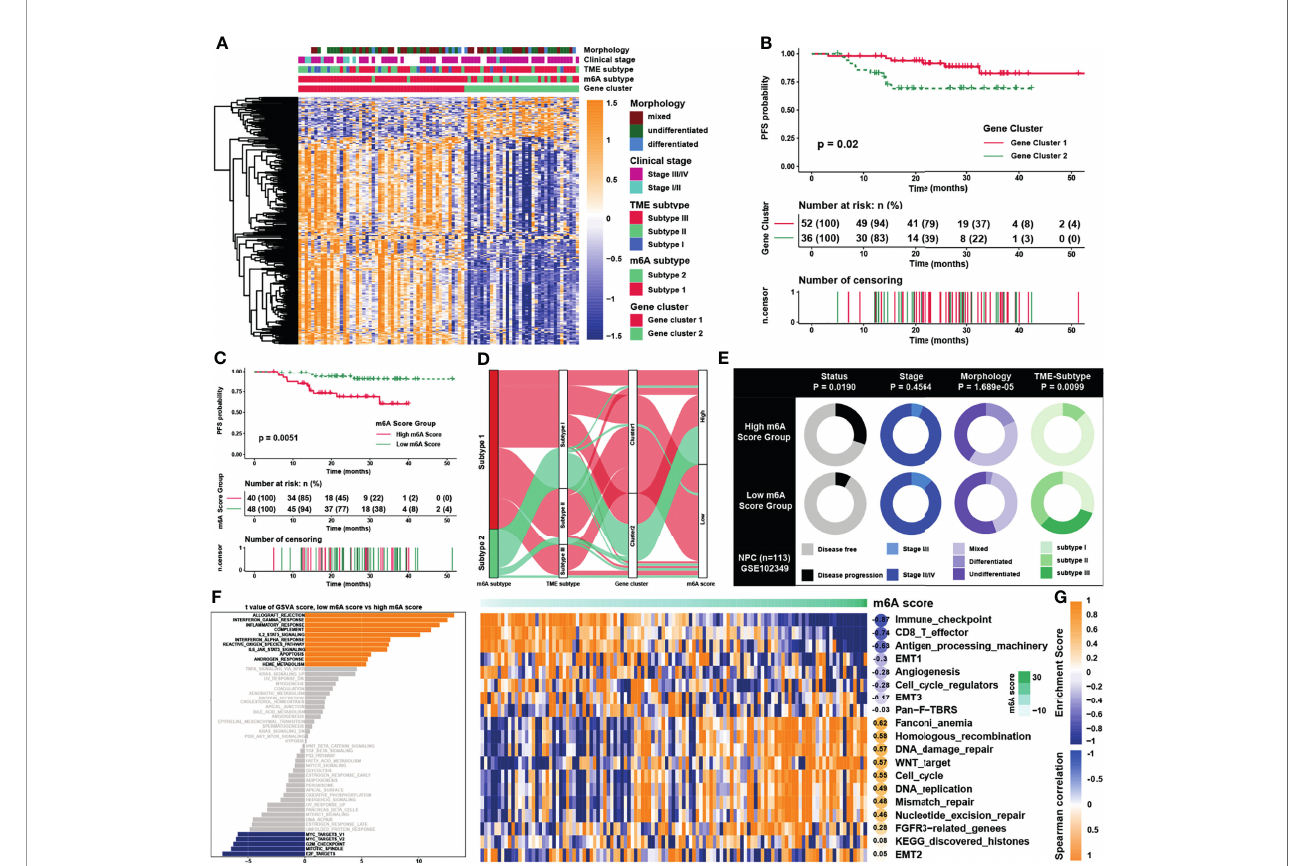
FIGURE 5 | Construction of m6A score and functional annotation. (A) An unsupervised clustering of overlapped m6A phenotype-related genes in GSE102349 to classify patients into different genomic subtypes, termed as m6A gene clusters 1 and 2, respectively. The gene clusters, m6A subtypes, TME subtypes, clinical stage, and morphology were used as patient annotations. (B) Survival analysis for m6A gene cluster in GSE102349. (C) Survival analysis for m6A score in GSE102349. (D) Alluvial diagram showing the changes of m6A subtypes, m6A gene clusters, TME subtypes, and m6A score. (E) Clinical characterization in low and high m6A score groups, and the chi-square test was used to calculate statistical differences. (F) The abundance of GSVA score for curated pathways in two m6A score groups. The orange and blue columns represented pathways enriched in low and high m6A score group, respectively. (G) Correlations between m6Ascore and the known gene signatures in NPC using Spearman analysis. Negative and positive correlations were marked in blue and orange,